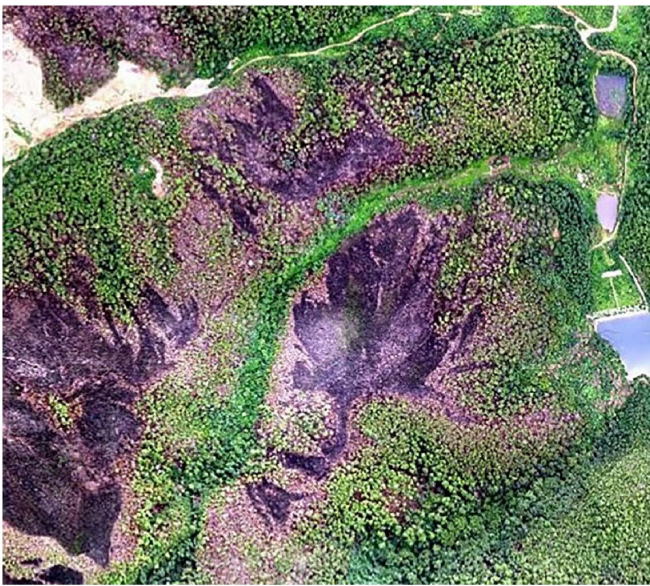
Figure 2. UAV remote sensing image of forest fire